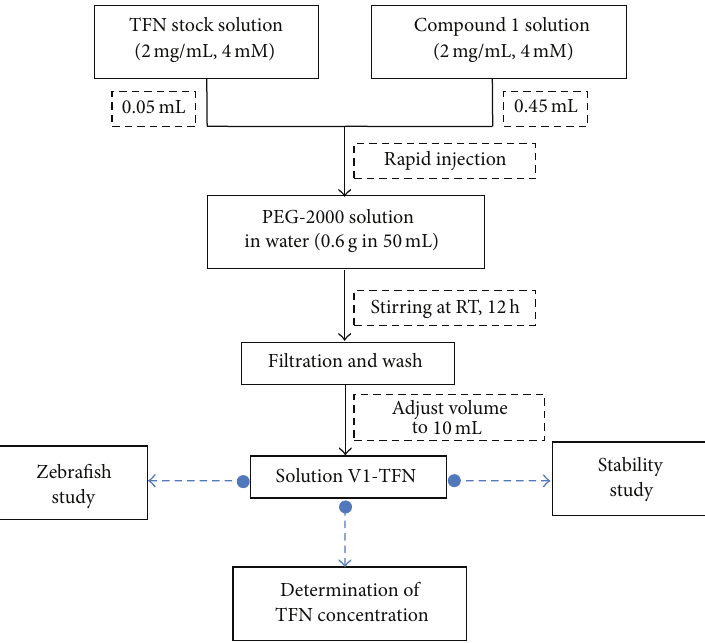
Figure 2: Schematic representation of TFN-loaded nanovesicles preparation.